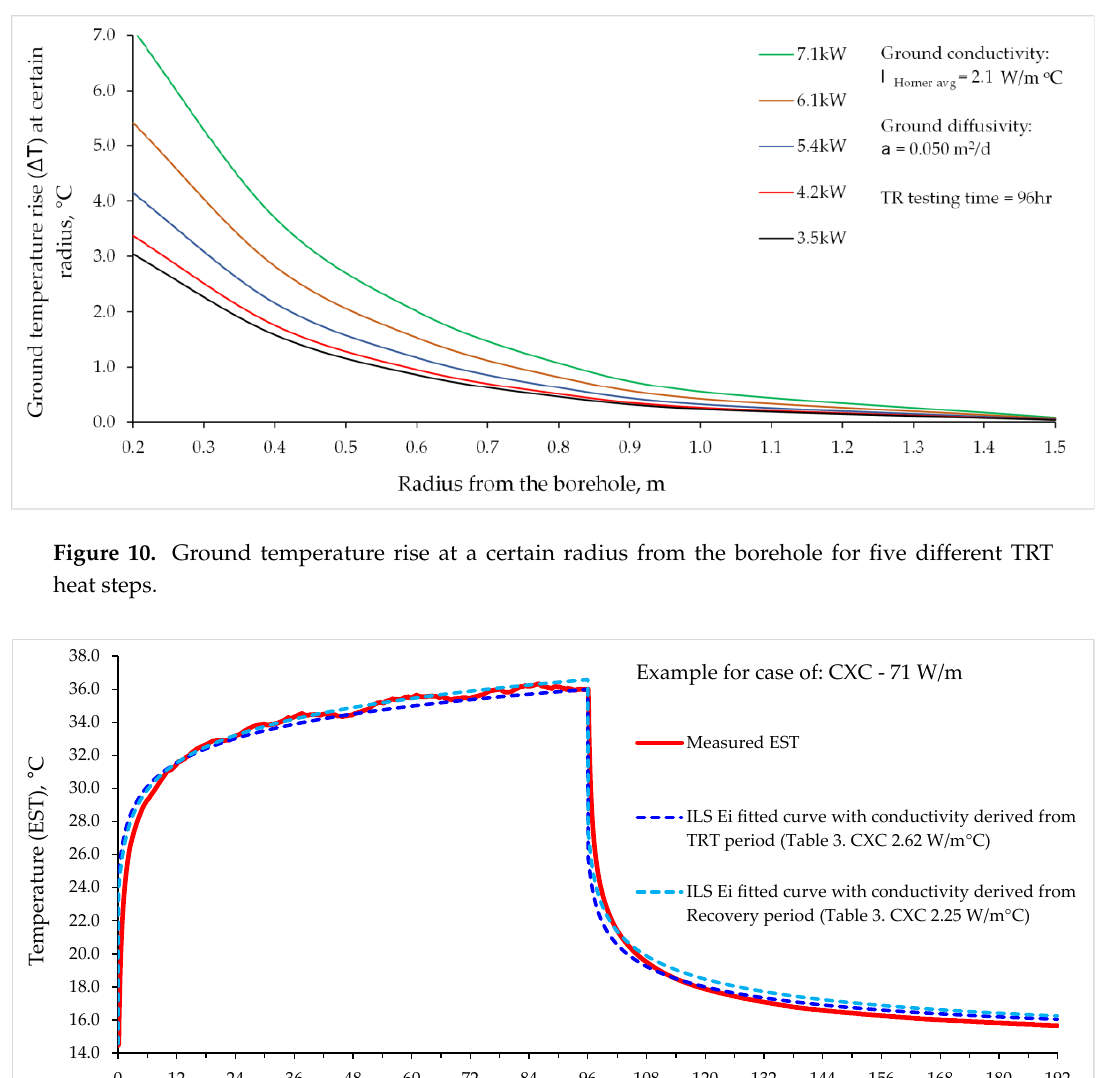
ILS Ei fitted curve with conductivity derived from TRT period (Table 3. CXC 2.62 W/m°C)